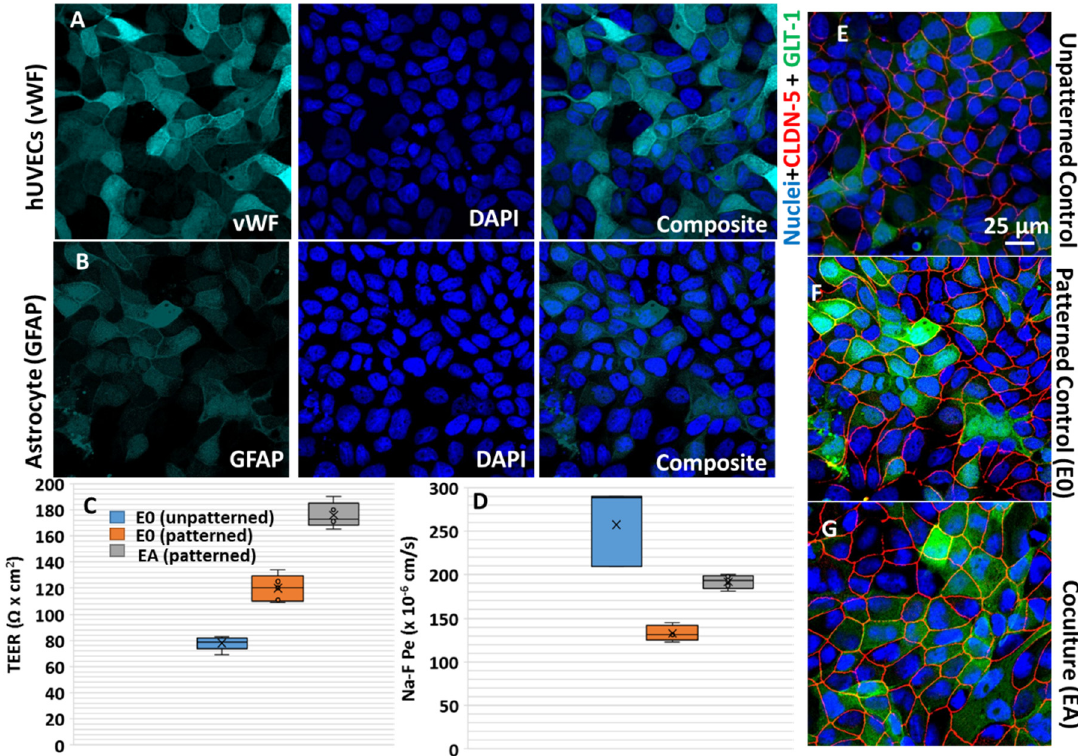
Figure 3. Barrier characterization by immunofluorescence and TEER measurement of hUVECs (patterned and unpatterned), micropatterned endothelial–astrocyte co-culture (EA): ( A ) endothelial cell characterization by expression of factor VIII-related antigen/von Willebrand factor; ( B ) astrocyte characterization was positive for glial fibrillary acidic protein (GFAP); ( C ) TEER for the unpatterned endothelial cells, patterned endothelial cells, and patterned co-culture are indicated in Ω cm 2 units; ( D ) permeability measurement of sodium fluorescein to determine the endothelial permeability coefficient expressed as Na − F Pe in × 10 − 6 cm/s. Expression of BBB-specific markers, such as glucose transporter 1 (GLUT − 1, green) and claudin-5 (CLDN − 5, red) counterstained with nuclei stain DAPI (Blue) in blood–brain barrier models constructed for brain endothelial cells under unpatterned ( E ), patterned ( F ), and patterned co-culture conditions ( G ).